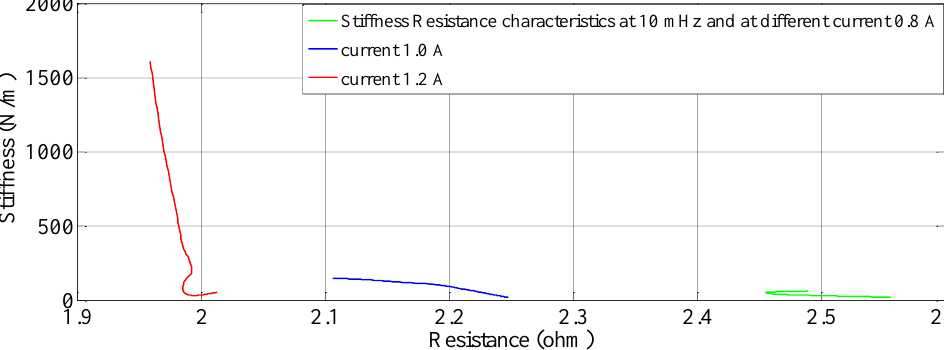
Figure 9. Stiffness − Resistance characteristics of the SMA spring actuator at different currents. Table 12. Resistance and Stiffness at different